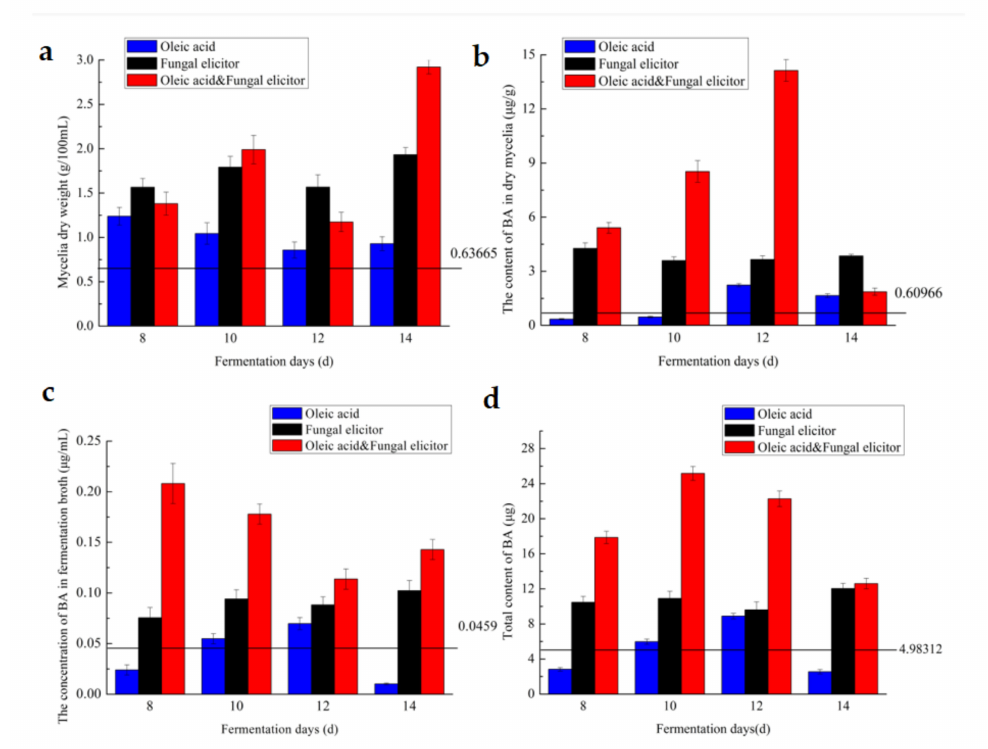
Figure 5. Effects of fermentation time on mycelia’s dry weight ( a ), the content of BA in dry mycelia ( b ), of the concentration of BA in fermentation broth ( c ) and the total content of BA ( d